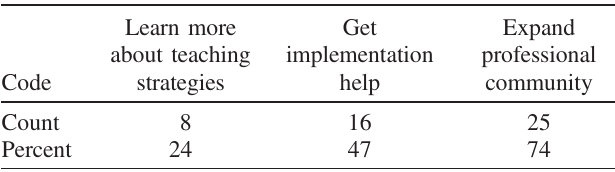
TABLE III. Specified motivations for joining the NFW-FOLC, beyond “ to improve my teaching. ” People could fall into more than one category. Count represents the number of participants coded to a category. Percentages are out of 34